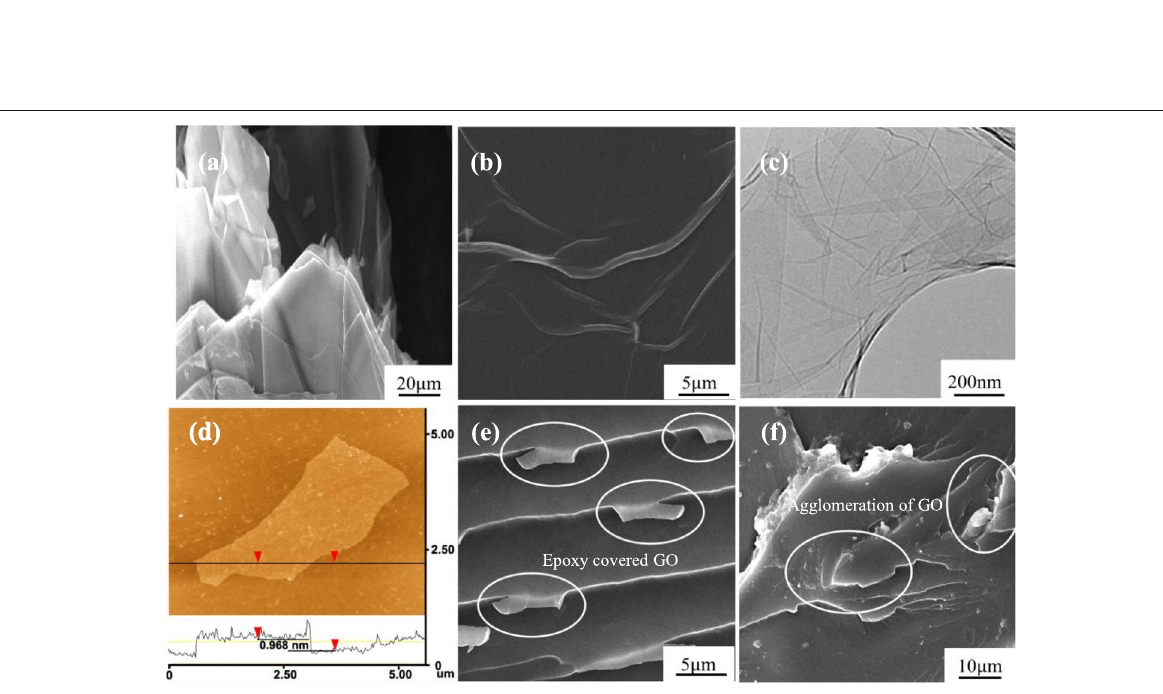
Fig. 2 Schematic illustration of the specimen for a DCB and b ENF test